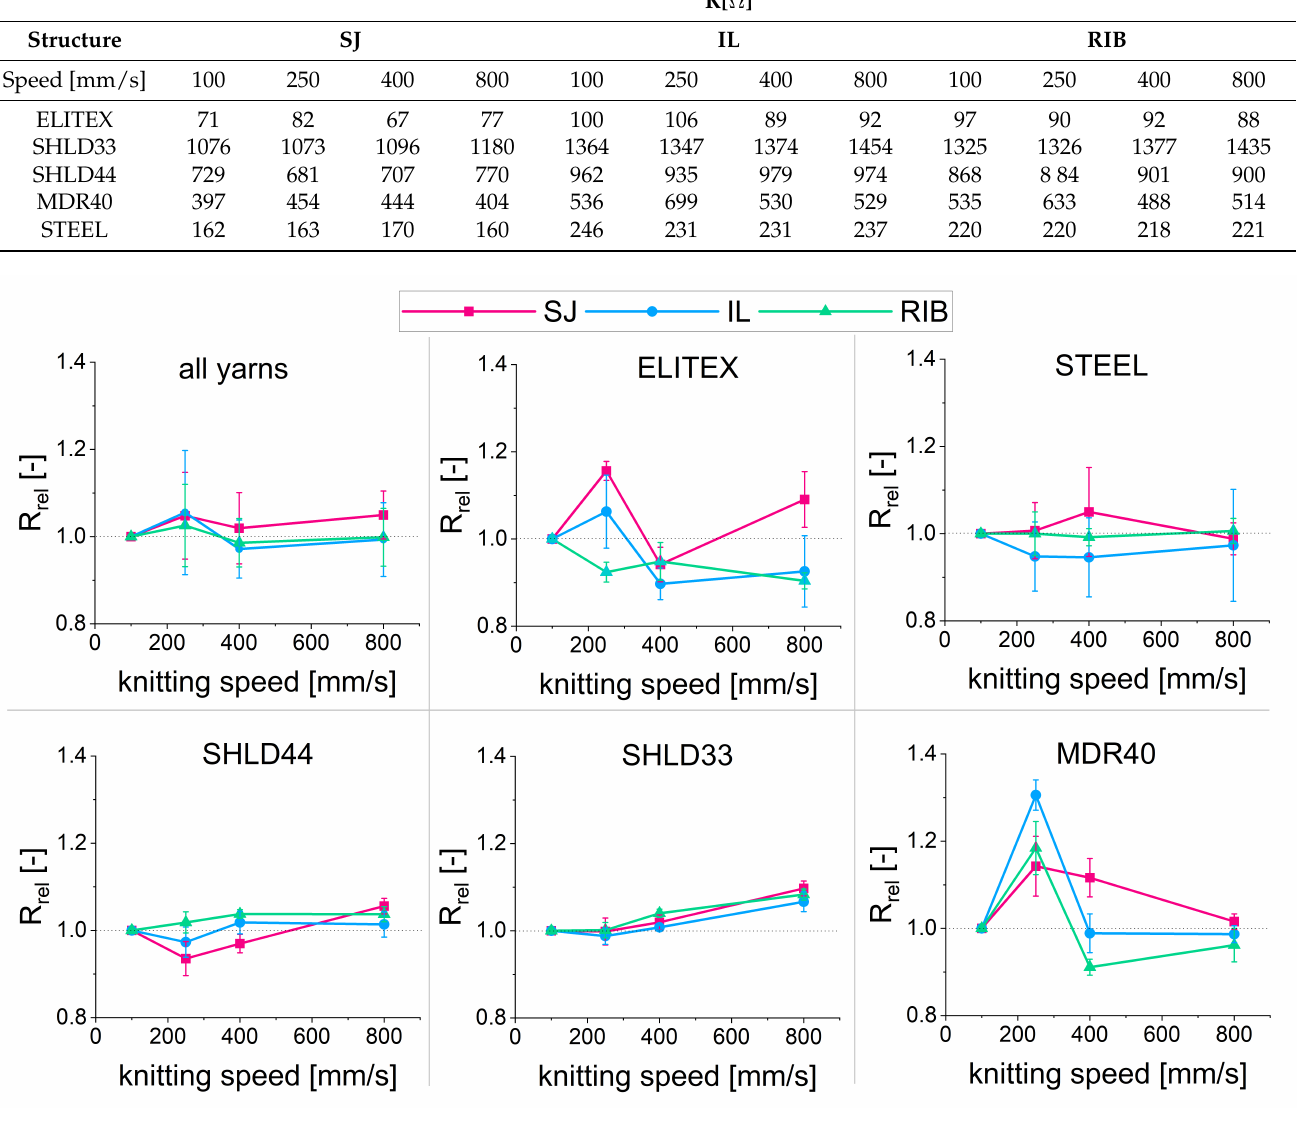
Figure 6. Resistance after knitting for different speeds, knit structures and